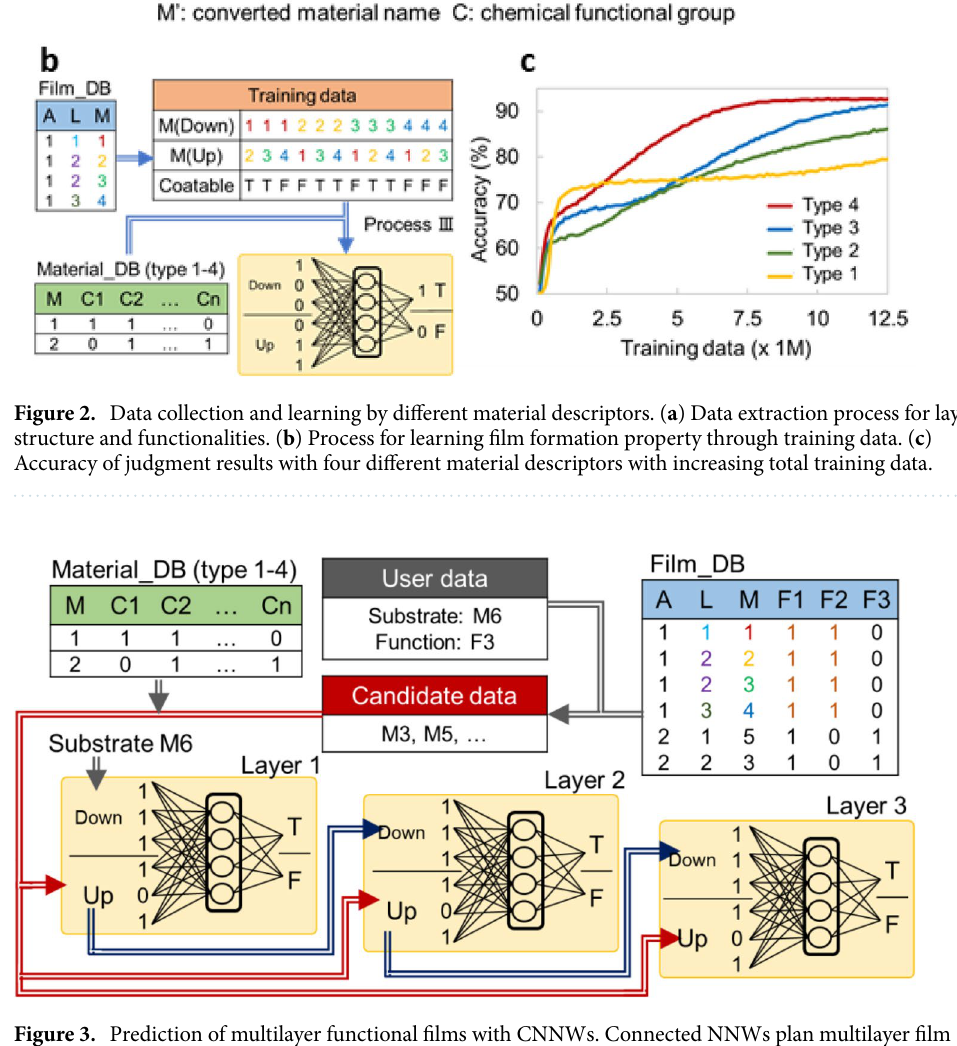
Figure 3. Prediction of multilayer functional films with CNNWs. Connected NNWs plan multilayer film structures from substrate to each layer in order. Through these processes, upper materials (latter process) on lower ones (former process) were gathered as stacked-layer